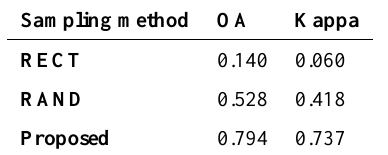
Table 1. Average accuracy of urban land-use classification via